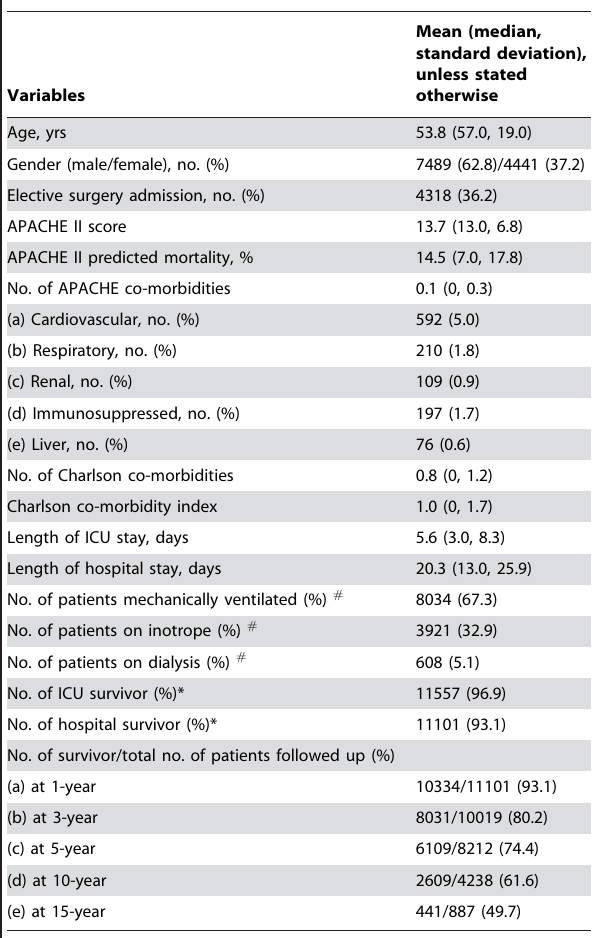
Table 2. Characteristics of the cohort (n